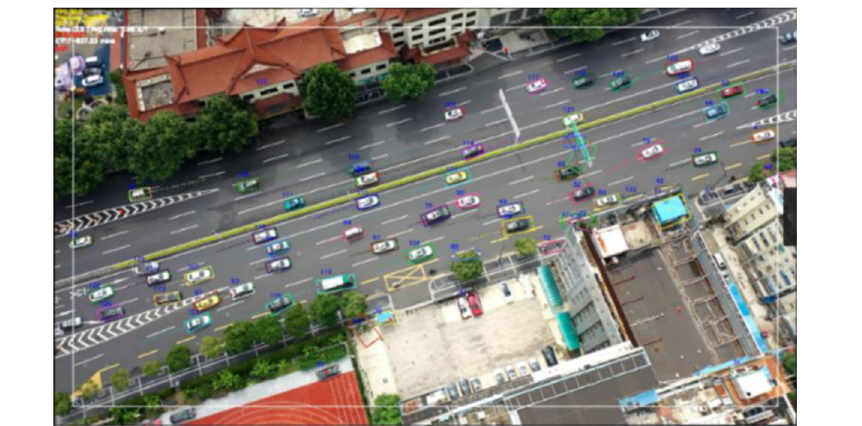
Fig 3. Video processing by using the automated roadway conflicts identification system.